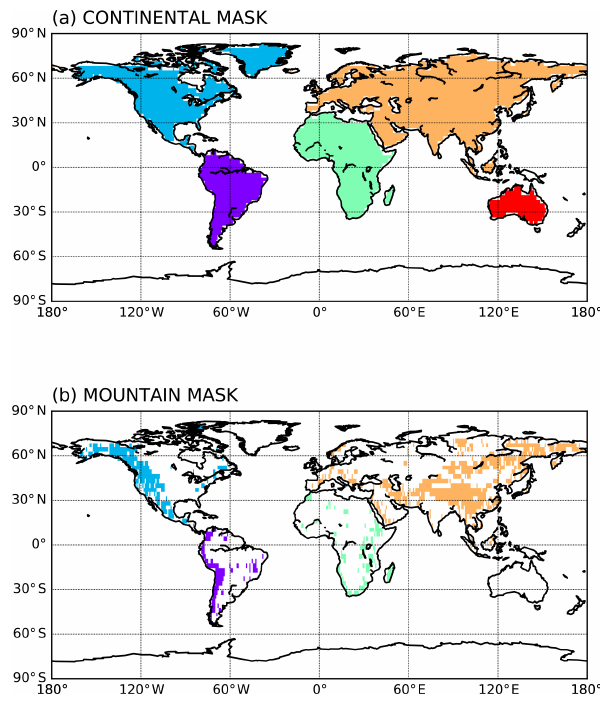
Figure 1. Spatial maps of the continental mask (a) with specific colors for each continent: blue for North America, pink for South America, orange for Eurasia, green for Africa, red for Australia and white for Antarctica. The associated mountain mask (b) for each continent containing